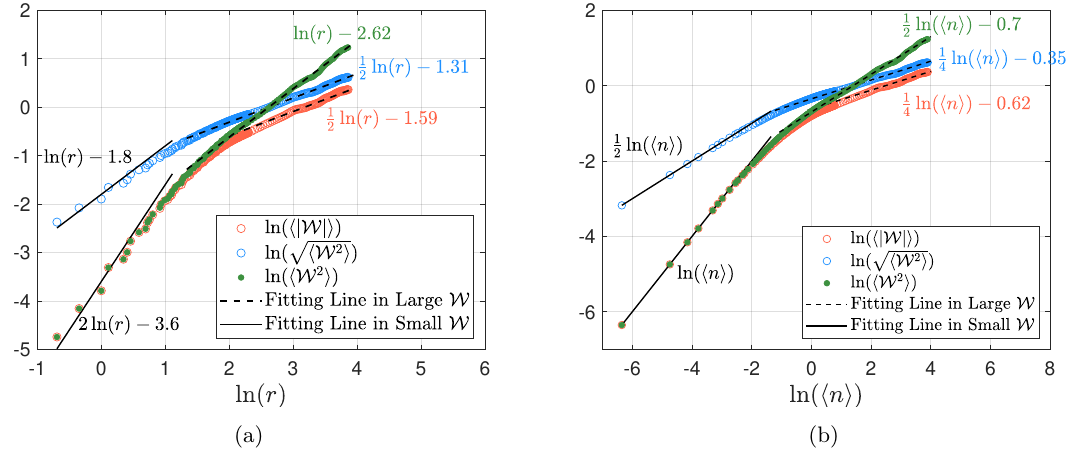
Figure 4. Universal scalings of typical winding number W . (a) Typical winding number W as a function of the size r of the contour C in which the defects are trapped. (b) Scalings between W and average total number of defects h n i trapped inside contour C . In panels (a) and (b) the data points were obtained by averaging 200000 runs for parameters τ Q = 30 and T f = 0 . 64 T c . Dots and open circles are the numerical data while the solid and dashed black lines are the fittings of the data in the small and large W limits,